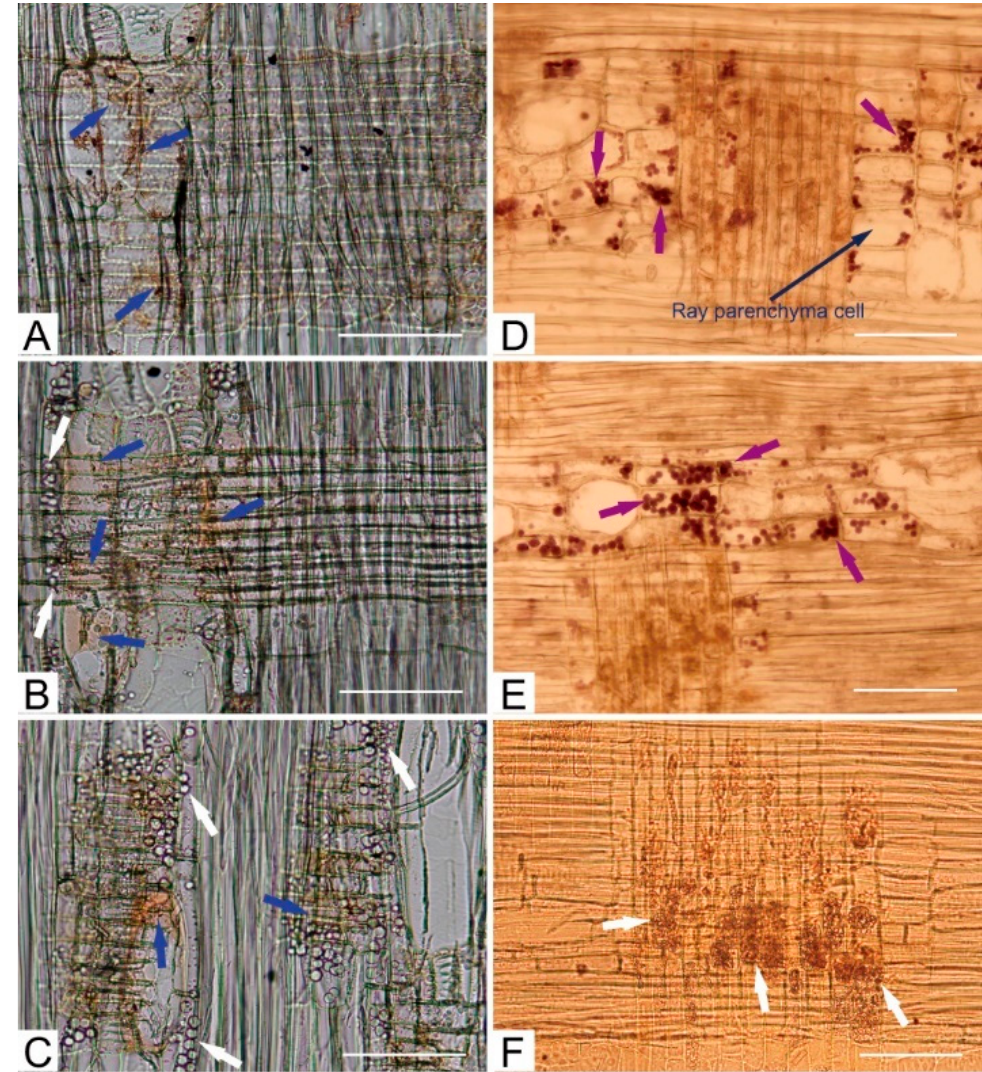
Figure 2. Light micrographs of starch grains, lipids, and extractives in P. hui radial sections. ( A – C ) SW, TZ, and HW sections stained with a Sudan IV solution showing lipids dyed orange ‒ yellow (blue arrows) and extractives (white arrows). ( D – F ) SW, TZ, and HW sections stained with a I 2 -KI solution showing starch grains (purple arrows) and extractives (white arrows). Bar = 10 μ m.